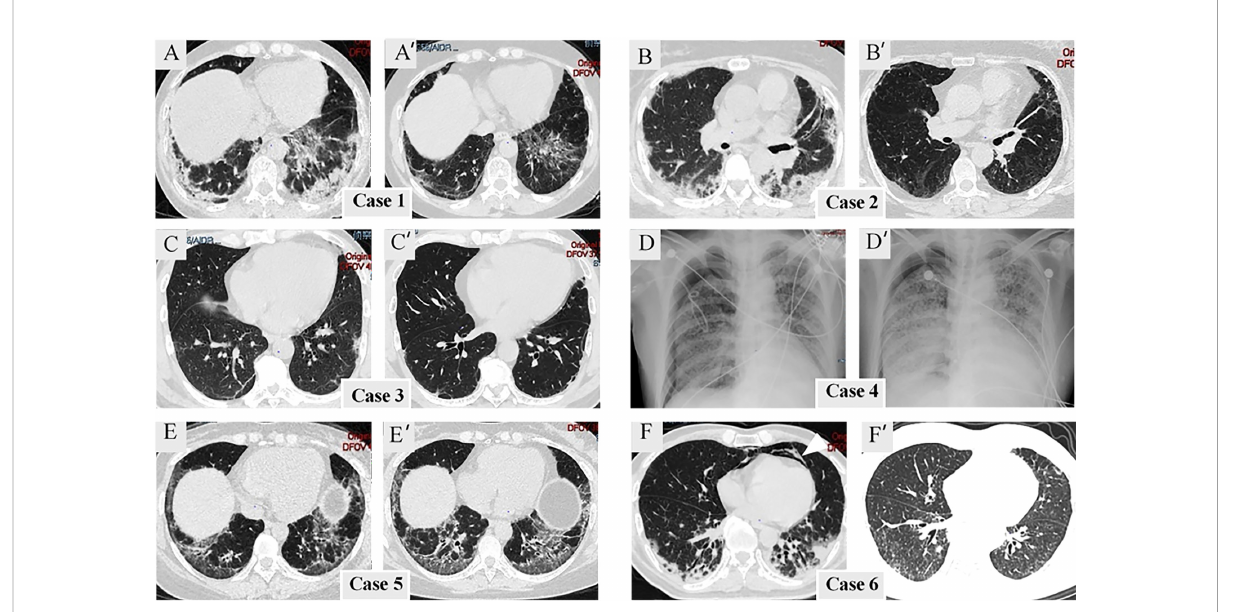
FIGURE 1 Radiological fi nding. (A – F) Radiological imaging at admission. (A ’– F ’ ) Radiological imaging following treatment. Mediastinal emphysema is indicated by the